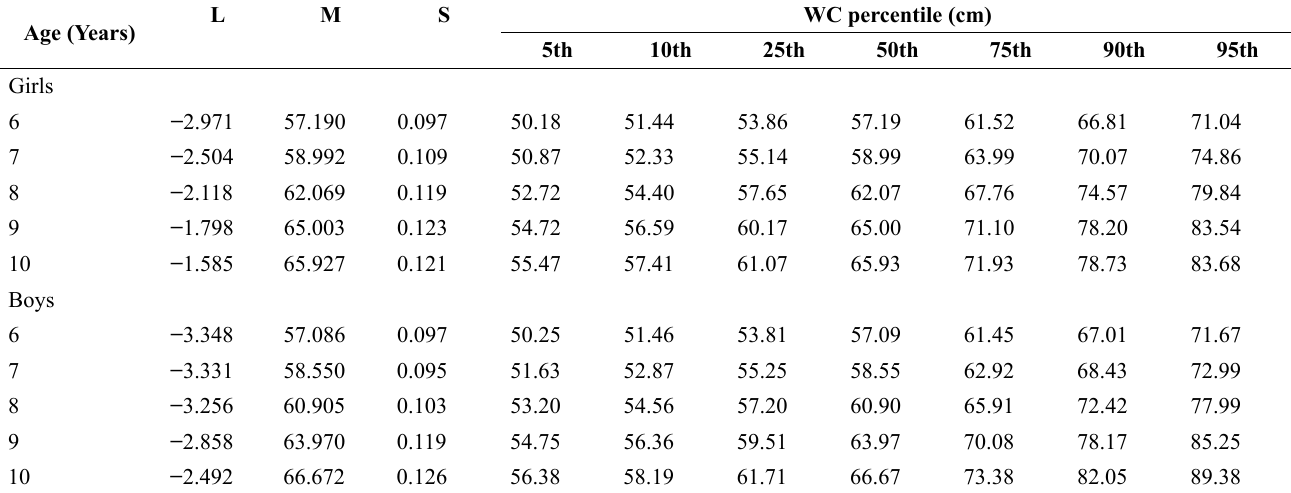
Table 2: Smoothed age-specific percentile values of waist circumference in Portuguese girls and boys L M Age (Years)